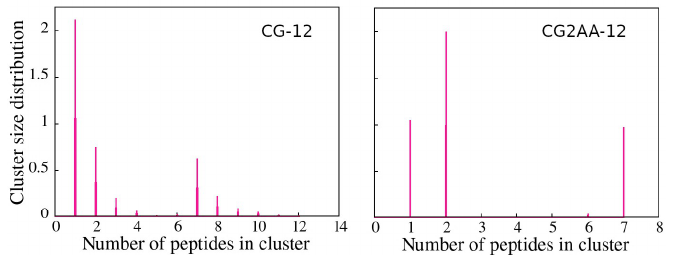
Figure 6. Cluster size distribution as a function of the number of peptides in a cluster, with the CG-12 simulation results on the ( left ) and the CG2AA-12 simulation results on the ( right ). The calculation was done with the clustsize Gromacs utility, with the condition that a peptide belongs to a specific cluster if the distance between its atom and any atom in the cluster is less than 0.35 nm. Other clusters properties, such as maximum cluster size, cluster size distribution, and representative cluster snapshots are provided in Section D of the Supplementary